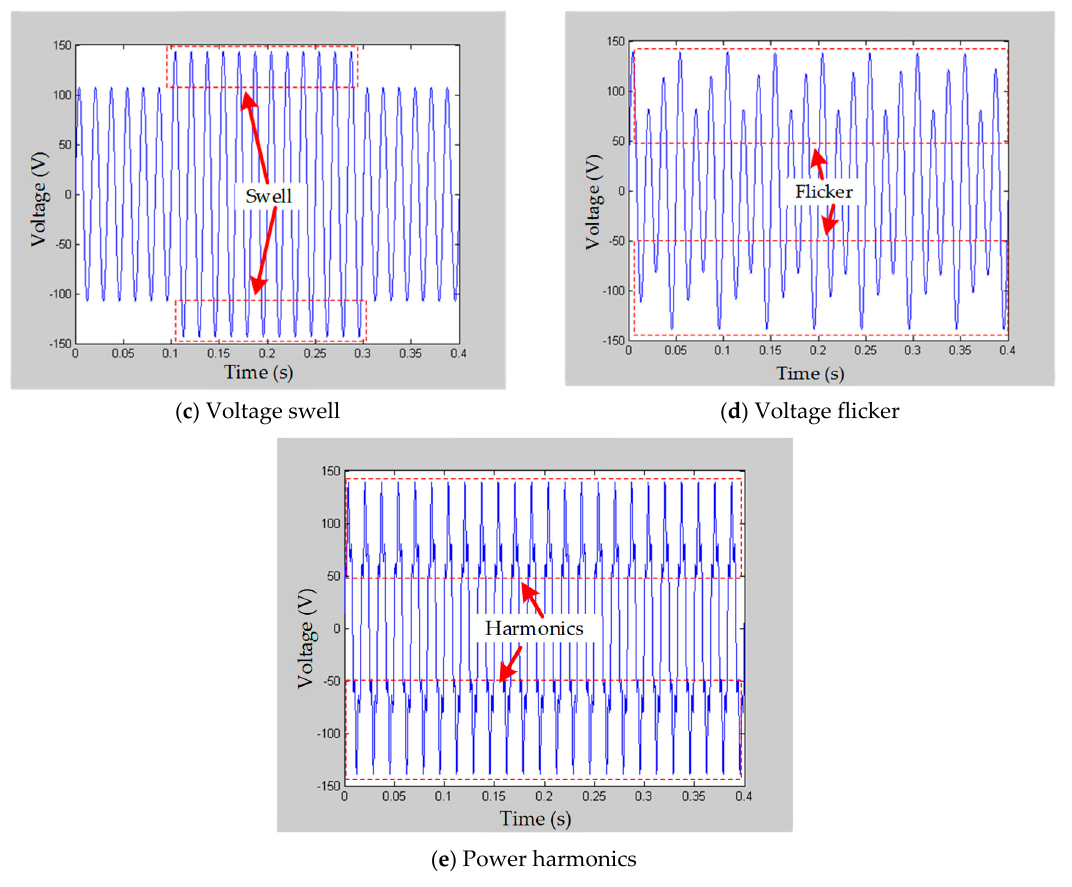
Figure 5. Power system signal with different disturbances: ( a ) power interruption; ( b ) voltage sag; ( c ) voltage swell; ( d ) voltage flicker; ( e ) power harmonics.